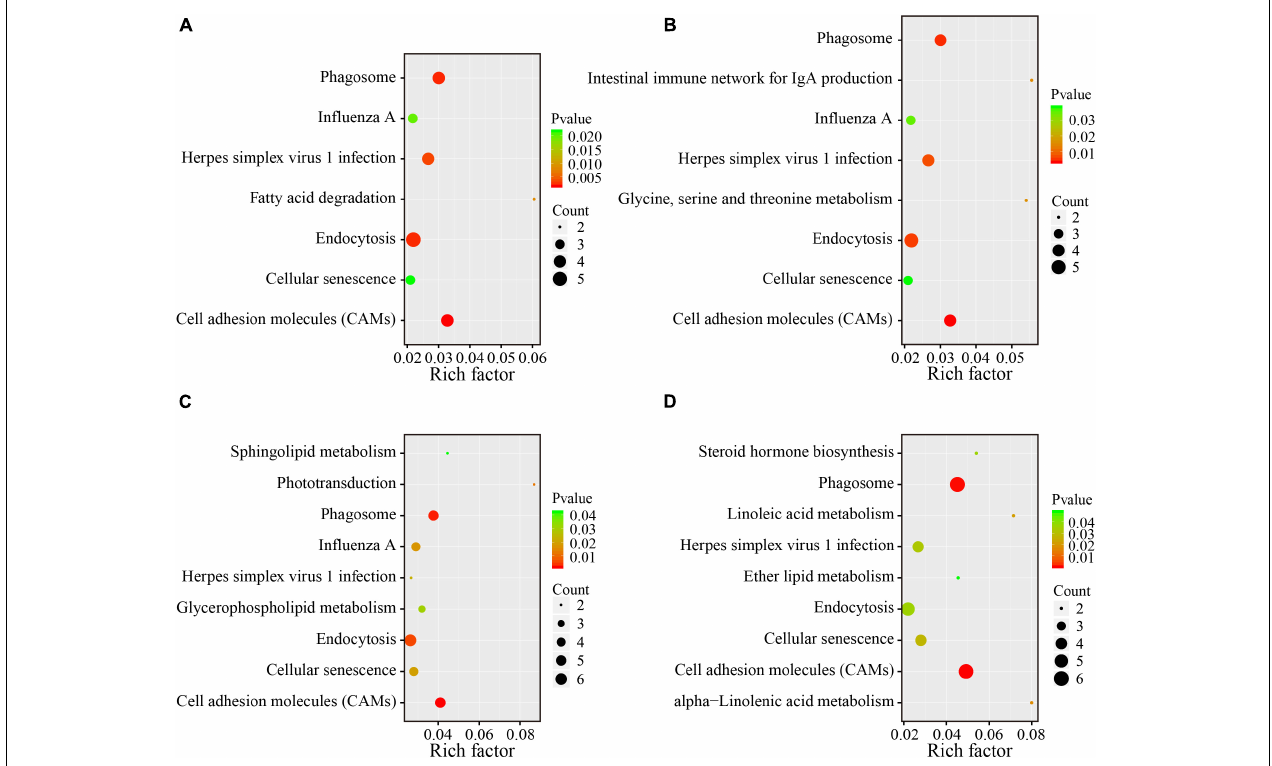
FIGURE 4 | KEGG pathway enrichment analysis of DEG between the two lines in four different intestinal compartments. The y -axis shows the name of the pathway, and the x -axis shows the Rich factor. The pathways with significant enrichment were shown in the KEGG scatter plot. The dot size represents the number of different genes, and the color indicates the p -value. The Rich factor is the proportion of the number of differentially expressed genes and the number of all annotated genes in a given pathway. The greater the Rich factor, the higher the degree of enrichment. (A) Duodenum; (B) jejunum; (C) ileum; (D)